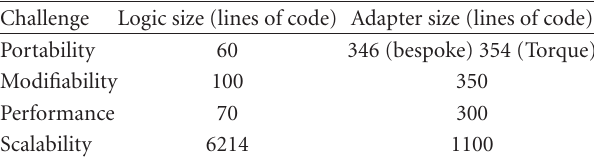
Table 2: The implementation overhead for the adapter.